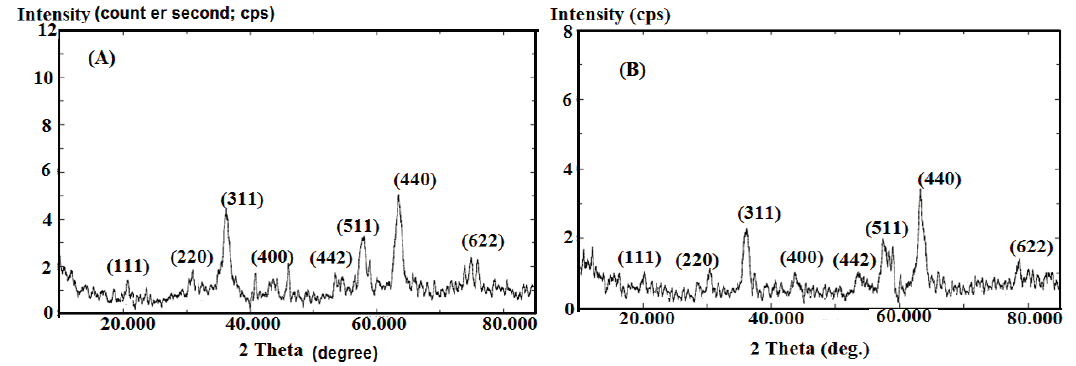
Figure 5. XRD diffractograms of magnetite coated with ( A ) R-AN and ( B ) RK-AN